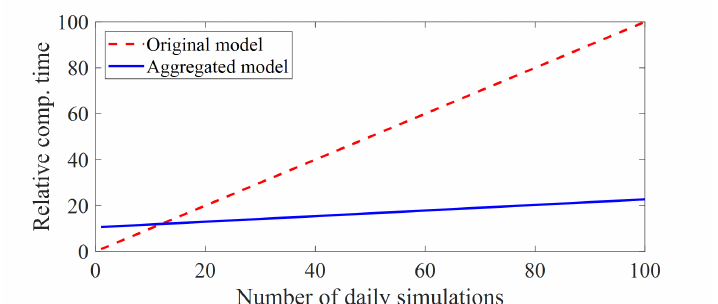
Figure 9. Relation between the number of daily simulations and relative computational